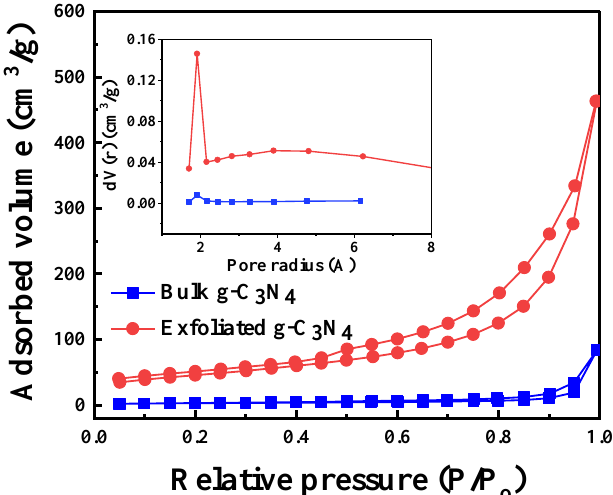
Figure 2. N 2 adsorption-desorption isotherms of bulk and exfoliated g-C 3 N 4 . The inset shows the corresponding Barrett–Joyner–Halenda pore size distribution curves of the samples.